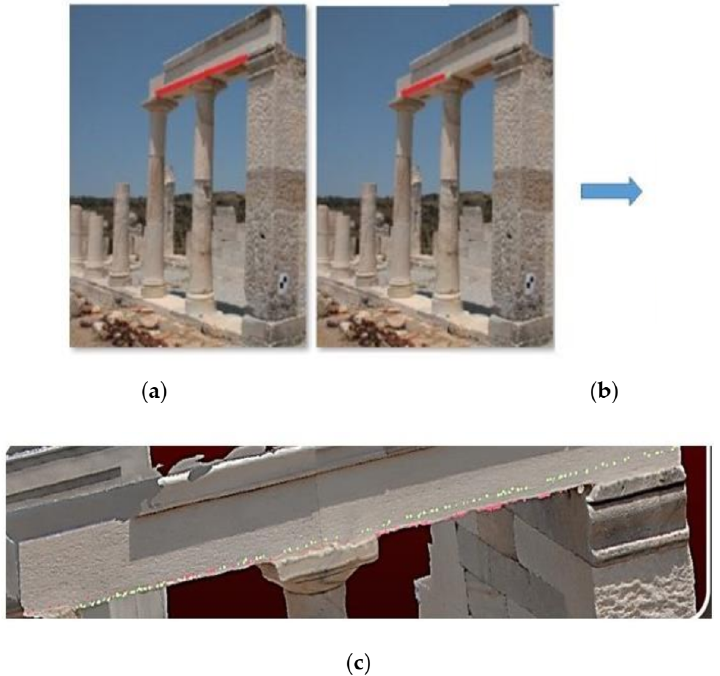
Figure 12. Display of the results of the algorithm when used on an edge depicting ( a ) the whole edge resulting in the pink edge in ( c ); and ( b ) a small part of the edge resulting in the white edge on ( c ). Finally, another problematic case is the depiction in the image of only one of the two sides of an edge (Figure 13a). Depending on the shooting angle this phenomenon may cause some problems for the algorithm. The rays from the camera “penetrate” the point cloud as shown schematically in Figure 13b and the algorithm fails. Depending on the angle of the camera axis, the points selected on the image are too close, but not exactly on the edge. The plane and the threshold used by the algorithm returns the two pink colored edges in Figure 13b, instead of the correct black one. This is attributed to the density of the point cloud and the fact that during scanning it is not certain that points exactly on the edge were registered by the scanner. The algorithm selects either of the two pink edges depending on whether the selected one is closest to the perspective center or back projected closer to the initially detected edge on the image. One suggestion for solving this problem is to limit the threshold or foresee a denser point cloud at the time of data acquisition.